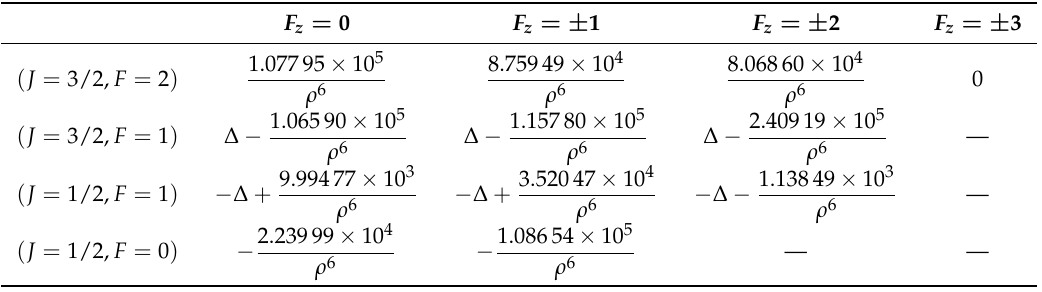
Table 2. Second-order van der Waals shifts for 6 P J hydrogen atoms interacting with ground-state hydrogen atoms. Entries marked with a long hyphen (—) indicate unphysical combinations of F and F z values. We denote the scaled interatomic distance by ρ = R / a 0 and give all energy shifts in atomic units, i.e., in units of the Hartree energy E h = α 2 m e c 2 . Recall that F z = F z , A + F z , B . The results still involve an averaging over the quantum numbers of the spectator atom; e.g., the results for J = 3/2, F = 2 and F z = 2 involve and averaging over the second-order shifts of the states | Ψ 9 (cid:105) and | Ψ 10 (cid:105) given in Equation (20e). We define ∆ in Equation